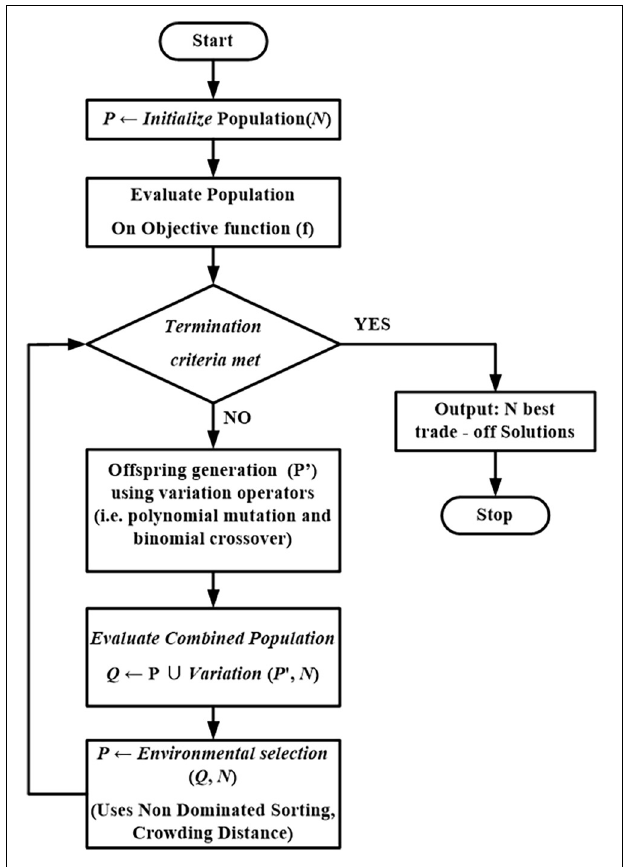
FIGURE 4 | Flowchart of non-dominated sorting genetic algorithm.